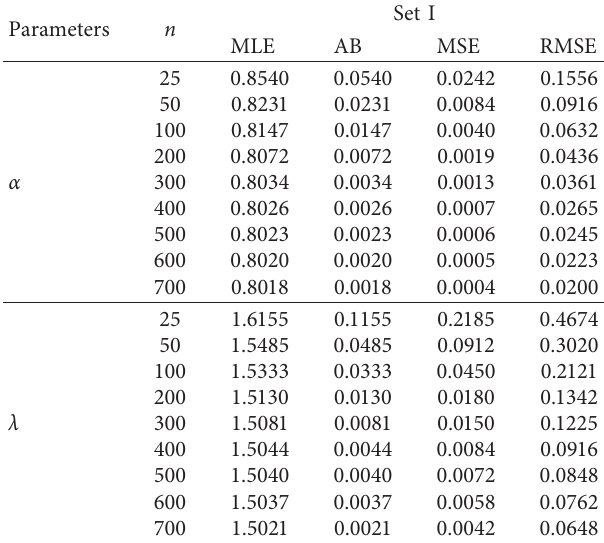
Table 3: Monte Carlo (MC) simulation results for the AT-W distribution using Set II values ( α � 0.8 and λ � 1.5).